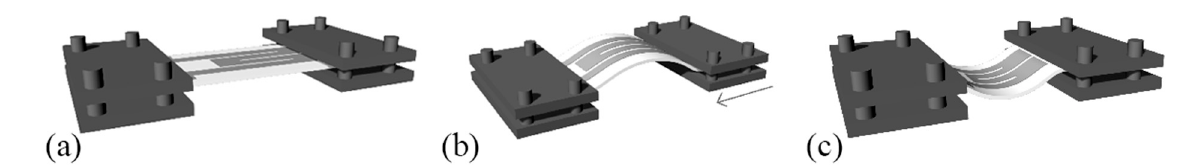
Figure 18. Different modes of mechanical deformation of a sample at rest ( a ); ( b ) tensile stress and ( c ) compressive stress.